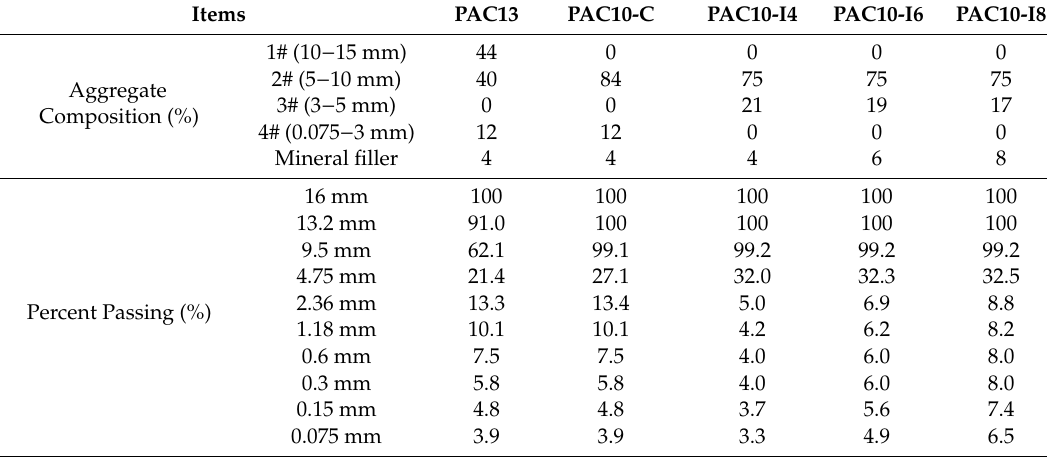
Table 4 were selected based on the following considerations: (1) PAC13 and PAC10-C have the same fine aggregate and mineral filler content, but di ff erent NMAS; (2) PAC10-C has the same NMAS as PAC10-I4, PAC10-I6, and PAC10-I8, but di ff erent fine aggregate contents; (3) PAC10-I4, PAC10-I6, and PAC10-I8 are the novel PACs with 4%, 6%, and 8% mineral filler, respectively. Table 4. PAC gradations for